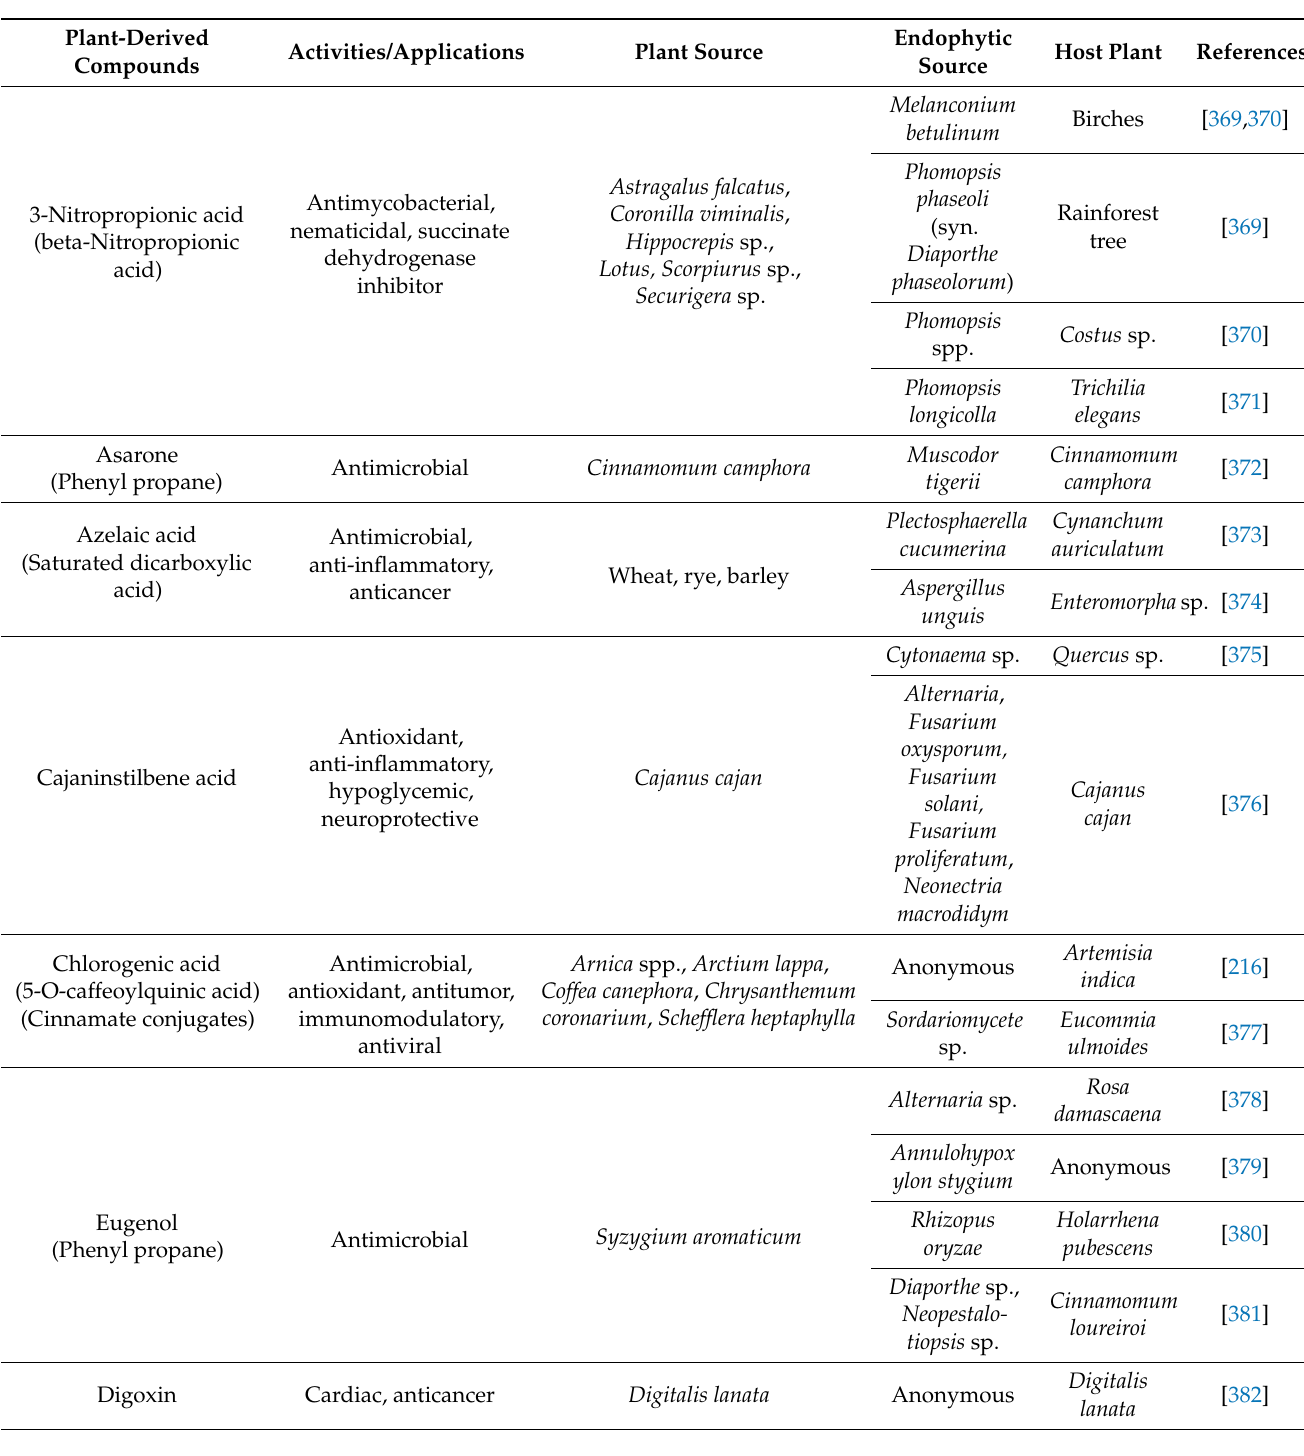
Table 8. Miscellaneous plant-derived compounds produced by endophytic